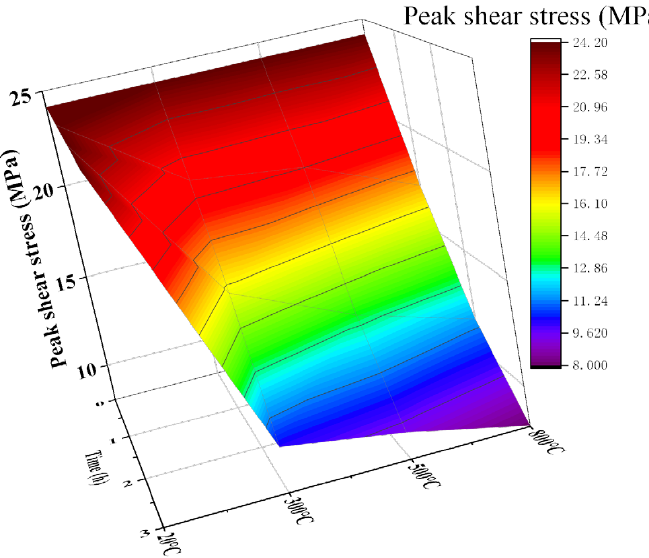
Figure 12. Shear strength of RTC (BG) under different geothermal conditions.